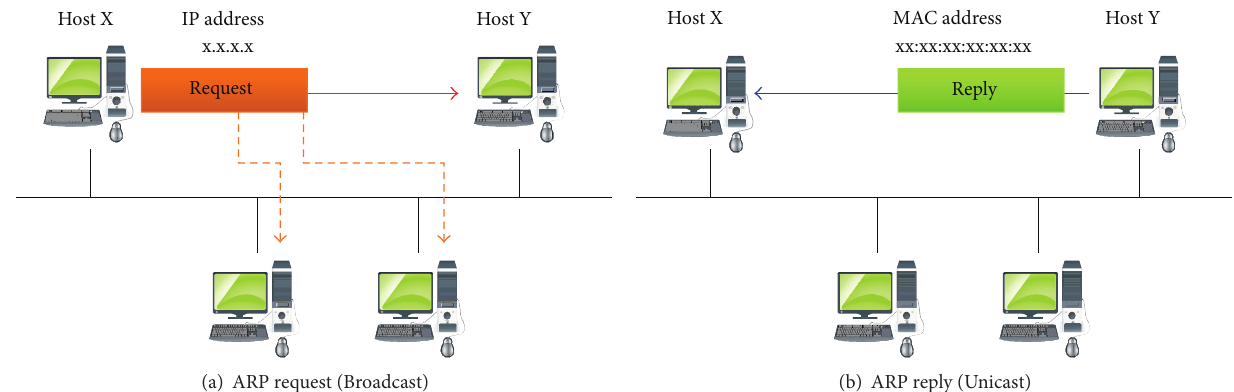
Figure 1: ARP request/reply